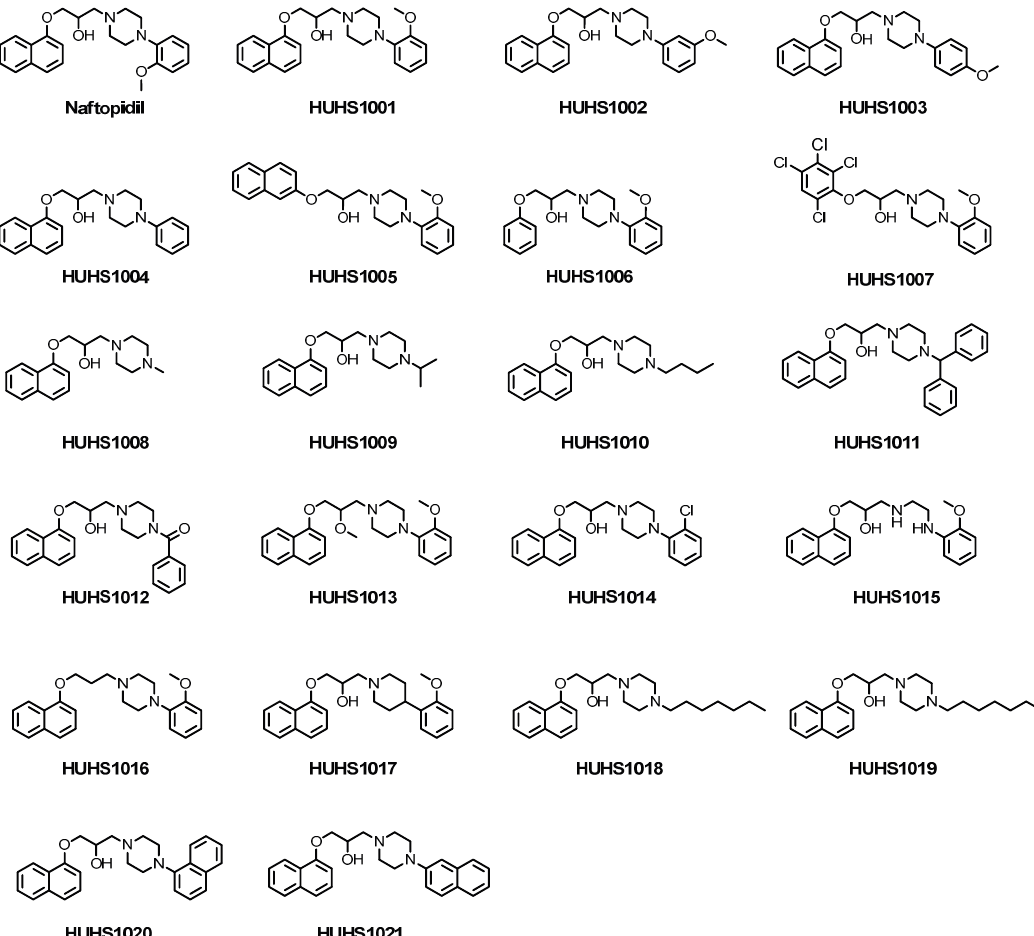
Figure 1. Chemical structures for naftopidil and newly synthesized naftopidil